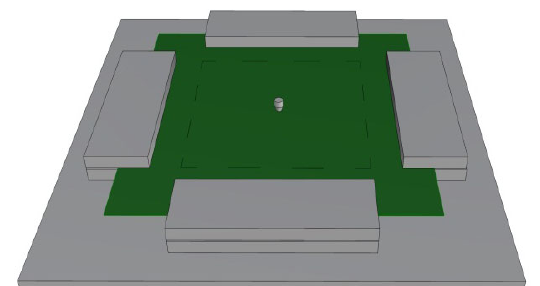
Fig. 3 Damage simulation of clamped CFRP plate. Table 1 Definition of damage states.